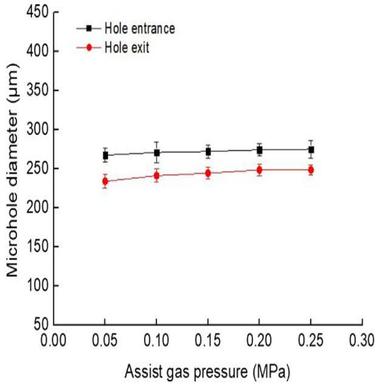
Influence of the argon pressure on the hole entrance and exit diameters drilled using 50 laser pulses.